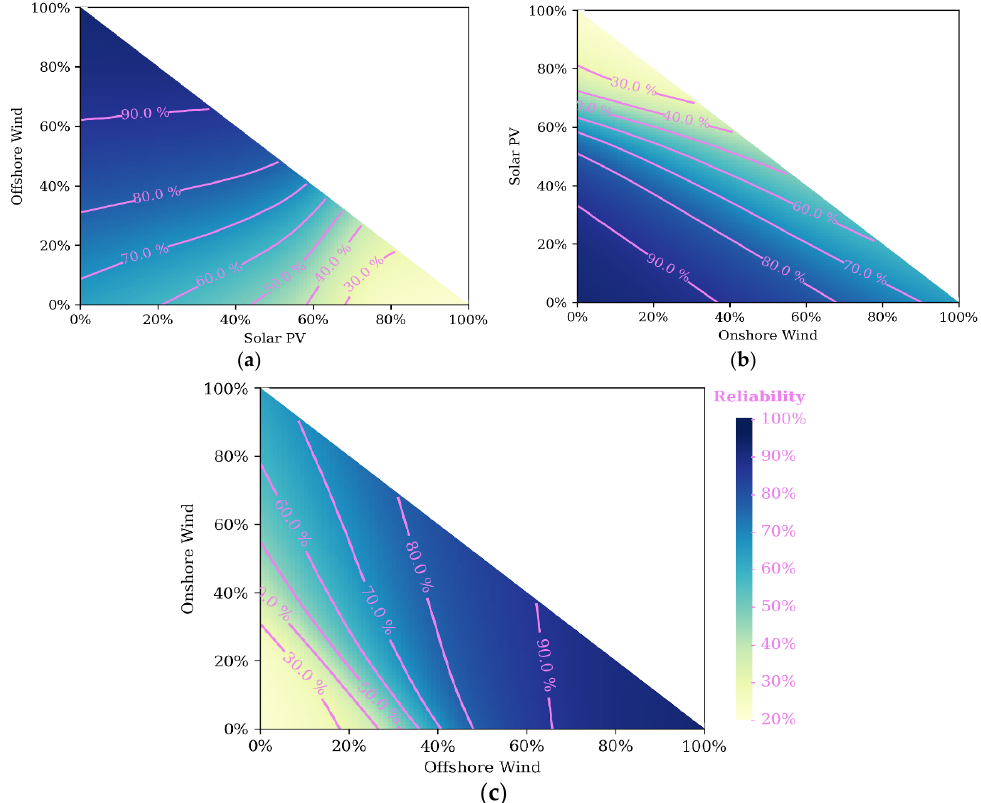
Figure 4. System reliability as a function of renewable capacity generation mix of solar PV, offshore wind and onshore wind with a total installed capacity of 100 GW and a fixed storage installed capacity of 300 GWh. Graph ( a ) shows reliability of mixtures of offshore wind and solar PV, Graph ( b ) shows reliability with mixtures of solar PV and onshore wind and Graph ( c ) shows reliability with mixtures of onshore wind and offshore wind.